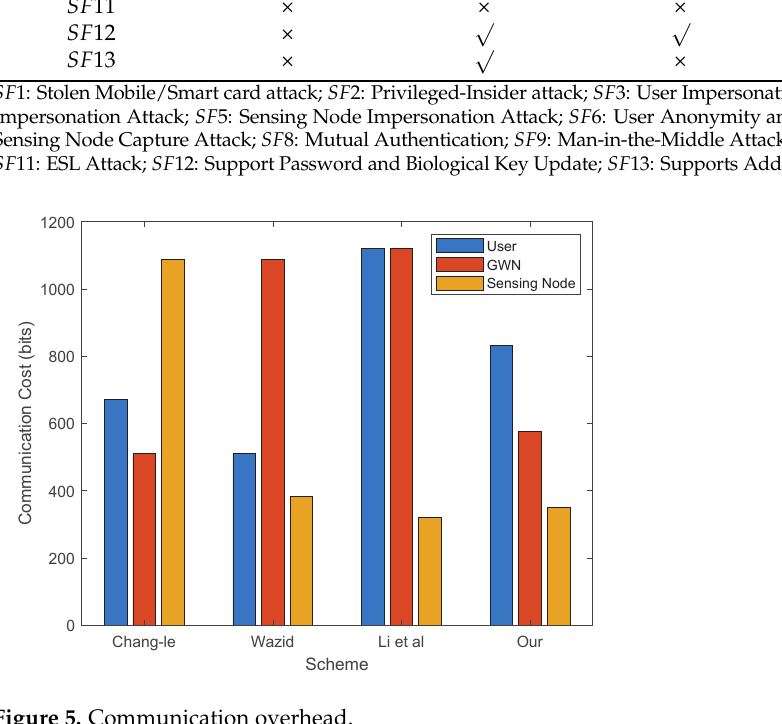
Figure 5. Communication